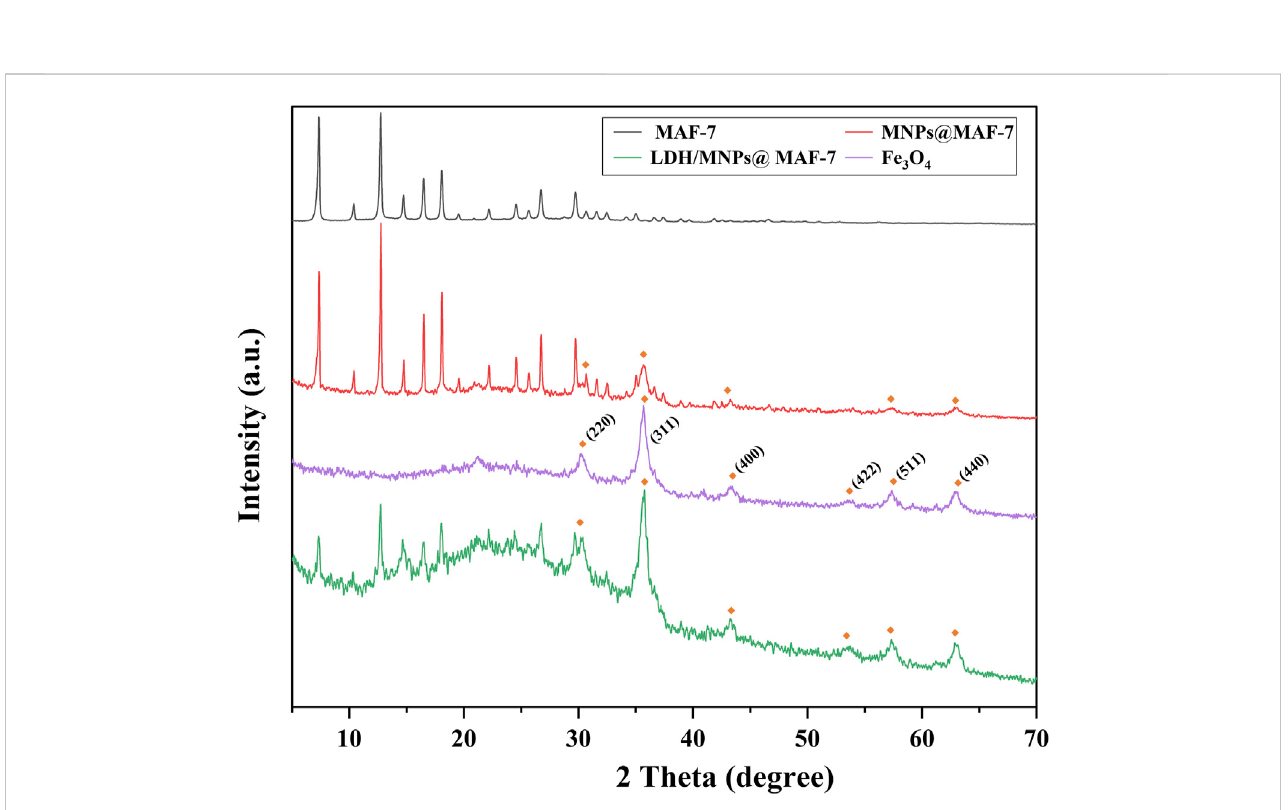
FIGURE 4 XRD patterns of MAF-7, MNPs@MAF-7, and